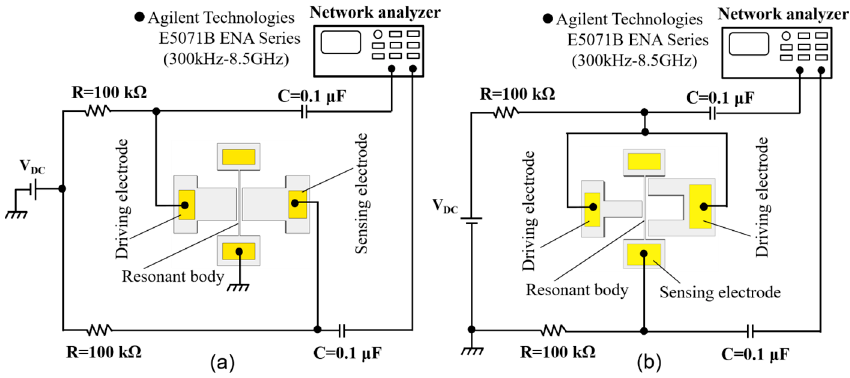
Figure 5. Measurement setups. ( a ) First mode vibration structure: ( b ) high-order mode vibration structure.